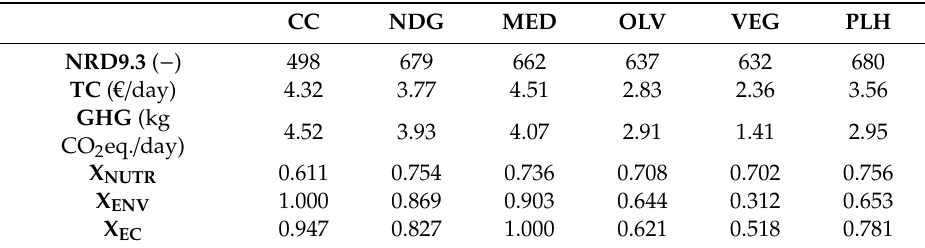
Table 2. Nutritional, economic, and environmental indexes of the pre-defined diets.